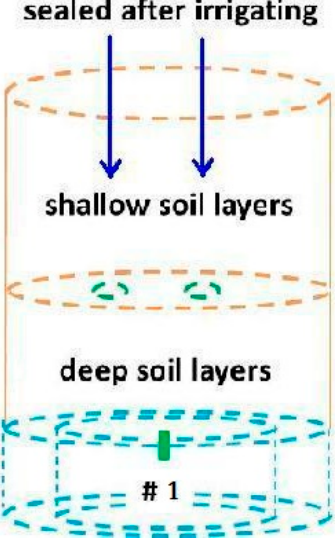
Figure 2. A diagram of the artificial soil ‐ groundwater system. The samples were collected from #1, with 6 replications.